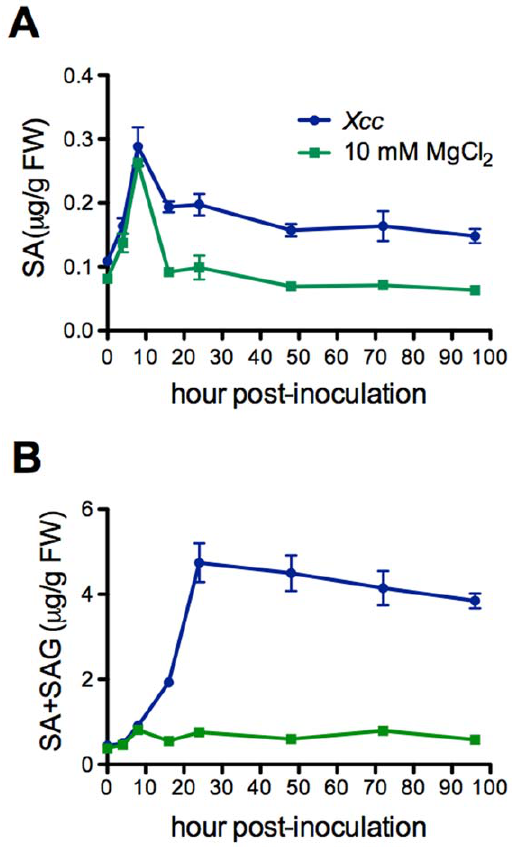
Figure 4. Xcc induces SA production in Arabidopsis. ( A ) Free SA levels. ( B ) Total SA (SA + SAG) levels. Leaves of wild-type Col-0 plants were inoculated with Xcc (OD 600 =0.02) or treated with 10 mM MgCl 2 . The inoculated leaves were collected at different time points (0, 4, 8, 16, 24, 48, 72, and 96 hpi) for SA measurement by HPLC. Data represent the mean of four independent samples with standard deviation. The experiment was repeated twice with similar results.